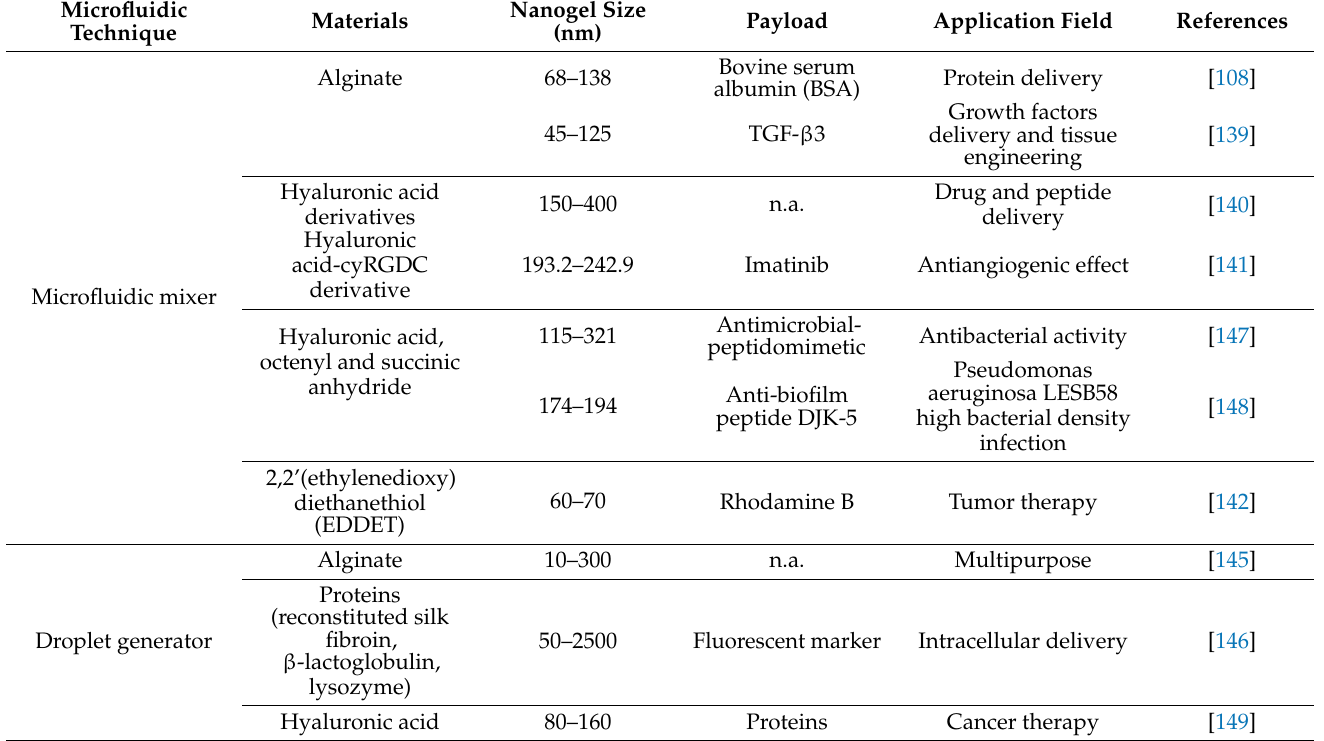
Table 2. Microfluidic approaches used in NG design (n.a. = not available drug release studies). Microfluidic